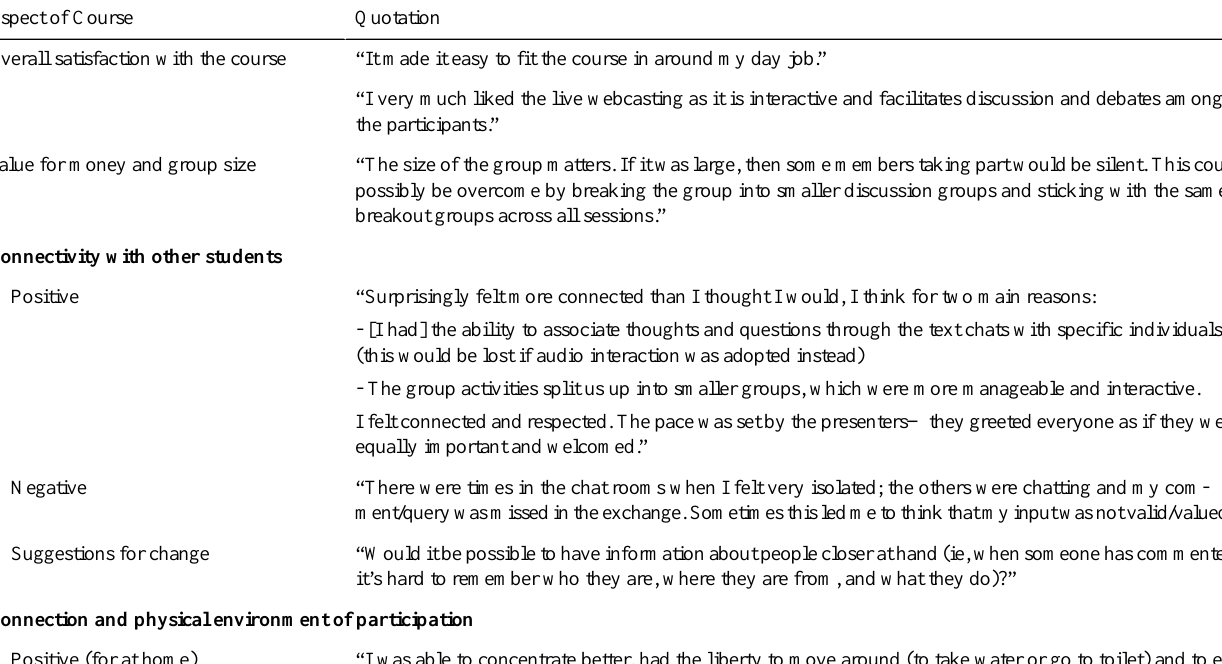
Table 2. Sample quotations from